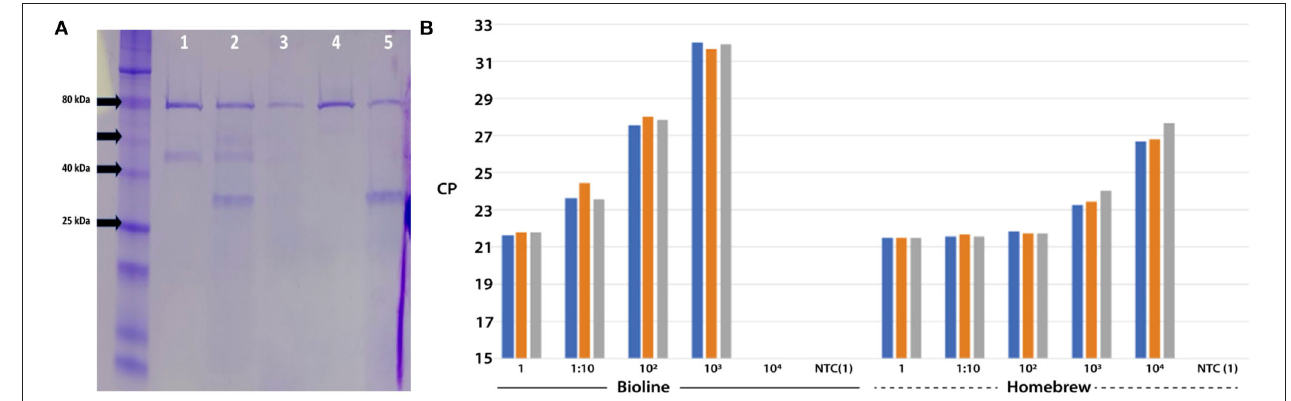
FIGURE 5 | (A) SDS Page of Reverse Transcriptase enzyme: Lanes (1) ab TES RT (2) ab TES RT + protease digest (3) ab TES RT + digest with inactivated protease (4) MashUp RT (5) MashUp RT + protease digest; (B) Cp in triplicate for serial dilution of MashUp RT compared to BioLine RT.